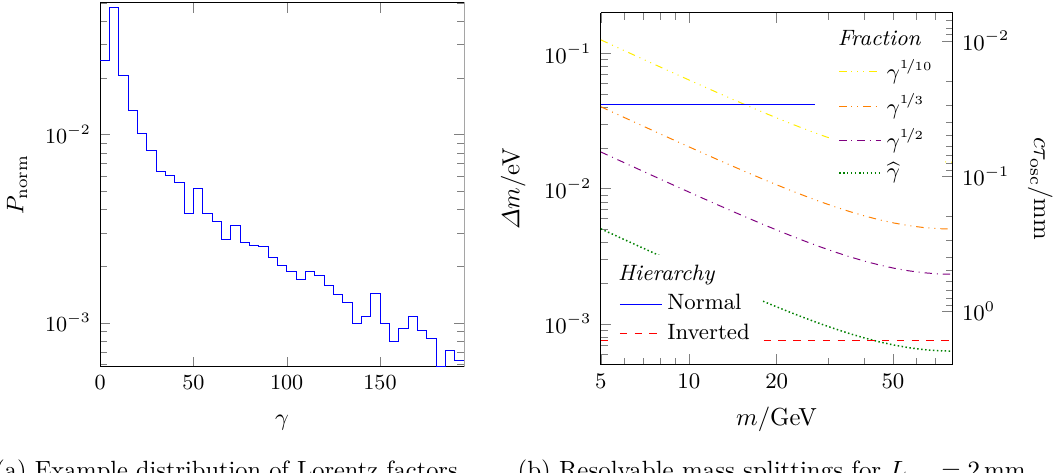
Figure 11 . Panel (a): histogram of the simulated Lorentz factor probability density function (PDF) for heavy neutrinos with a mass of 7 GeV. Panel (b): resolvable mass splittings for a fixed oscillation length of L osc = 2 mm for event samples with different Lorentz factor thresholds γ f . The horizontal lines correspond to the mass splitting appearing in the two minimal linear seesaw BMs given in table 1